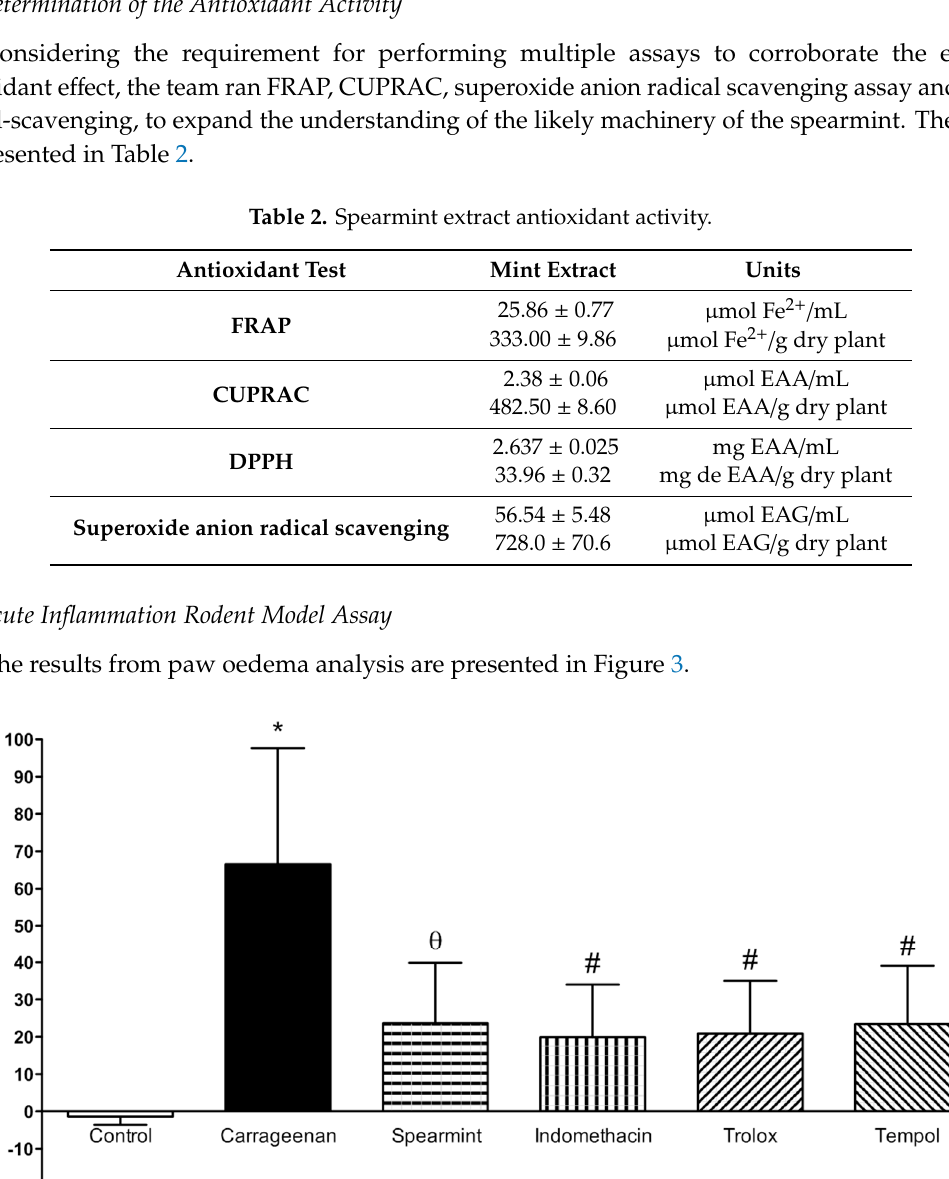
Table 2. Spearmint extract antioxidant activity.